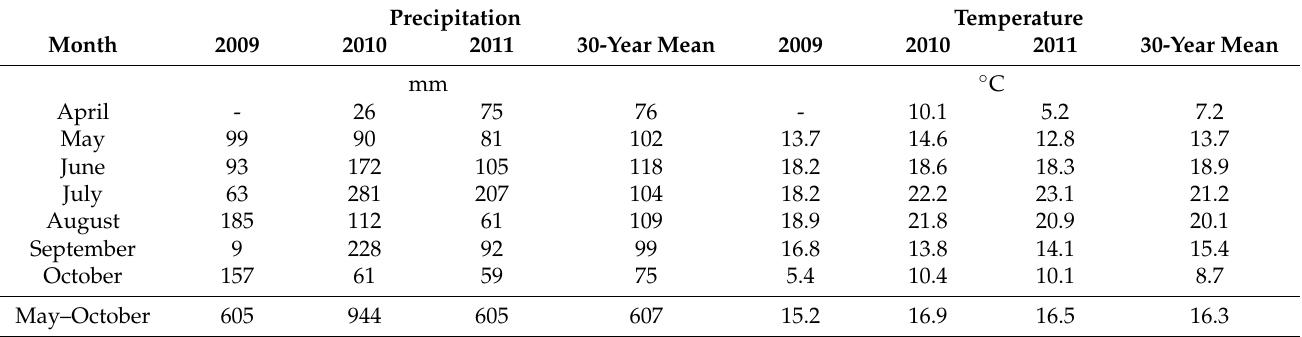
Table 2. Monthly mean precipitation and temperatures. April 2009 precipitation and temperature were both unavailable due to a logger